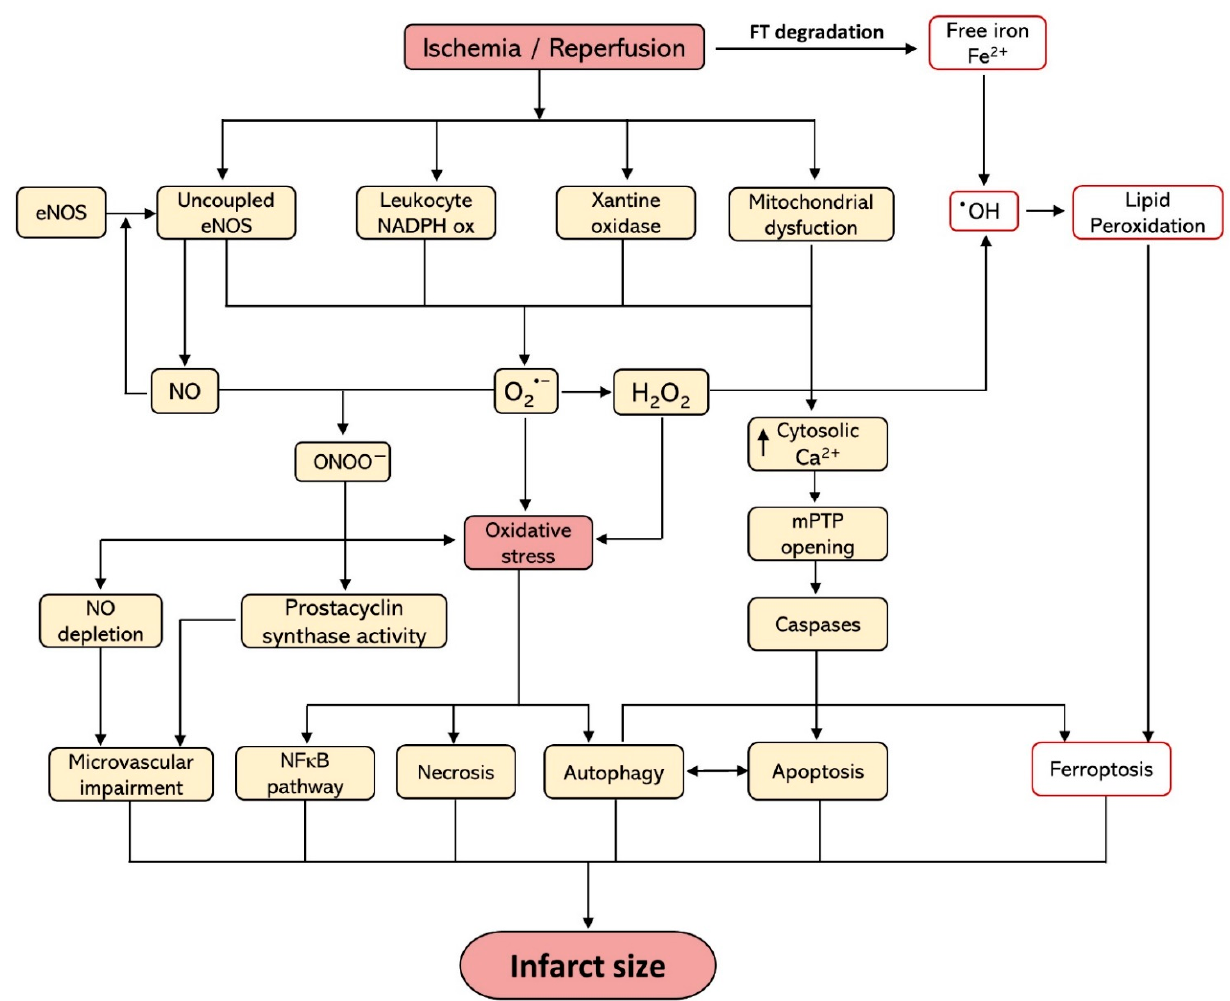
Figure 1. Schematic diagram of the main contributory oxidative stress-related factors involved in the pathophysiology of myocardial damage due to ischemia-reperfusion. eNOS, endothelial nitric oxide synthase; Fe 2+ , ferrous iron; FT, ferritin; H 2 O 2 : hydrogen peroxide; mPTP, mitochondrial permeability transition pore; NADPH ox, reduced nicotine adenine dinucleotide phosphate oxidase; NO, nitric oxide; O 2• − , superoxide radical anion; • OH, hydroxyl radical; ONOO − , peroxynitrite anion.